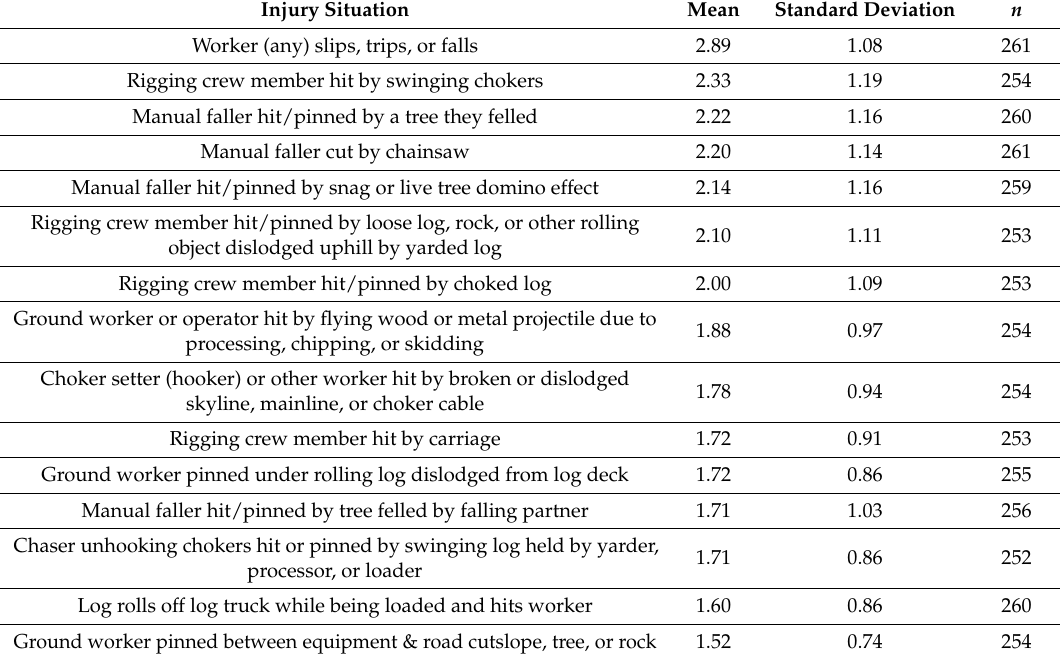
Table 6. Survey respondents’ evaluation of how common select injury incidents relevant to ground workers are on logging operations in the Inland Northwest, average of 1 to 5 scale (1 = not at all common, 5 = very